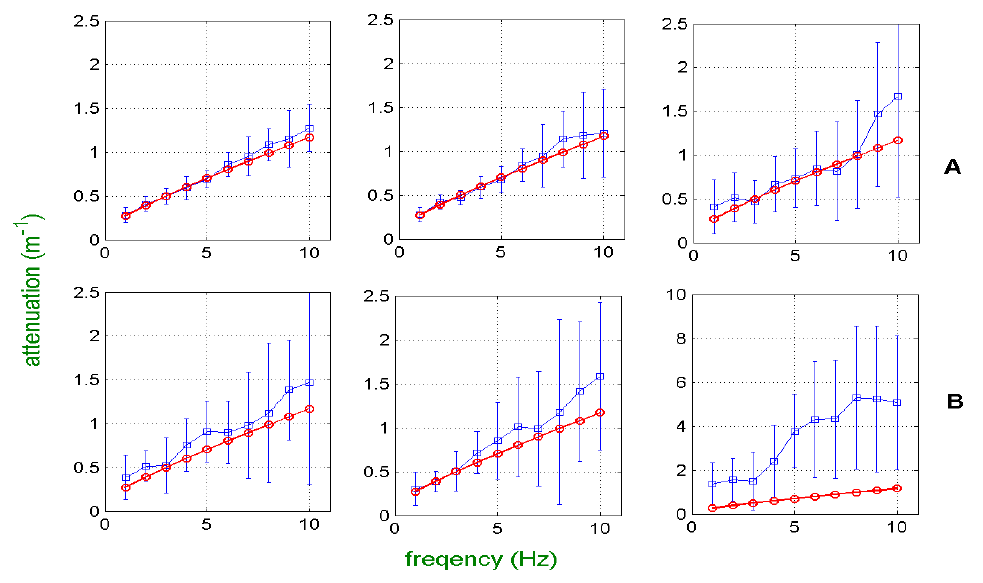
Fig. 9 Attenuation as function of frequency obtained by analysing noisy data (4%) with the three methods: A ( d =15 cm), B ( d =5 cm). Circles represent input attenuation. Square is the mean attenuation and bars is standard error of 20 noise simulation. The panels in the column show data from RV-I method, the panels in the central column show data from RV-II method, and the panels in the right show data from three-point method. L =44.3cm, R 0 =2.59 mm, K 0 =0.68, (cid:2242) (cid:2777) = (cid:2778)(cid:2779) (cid:2197) , E =8.21 10 5 Pa, (cid:2246) = 3.53 10 -3